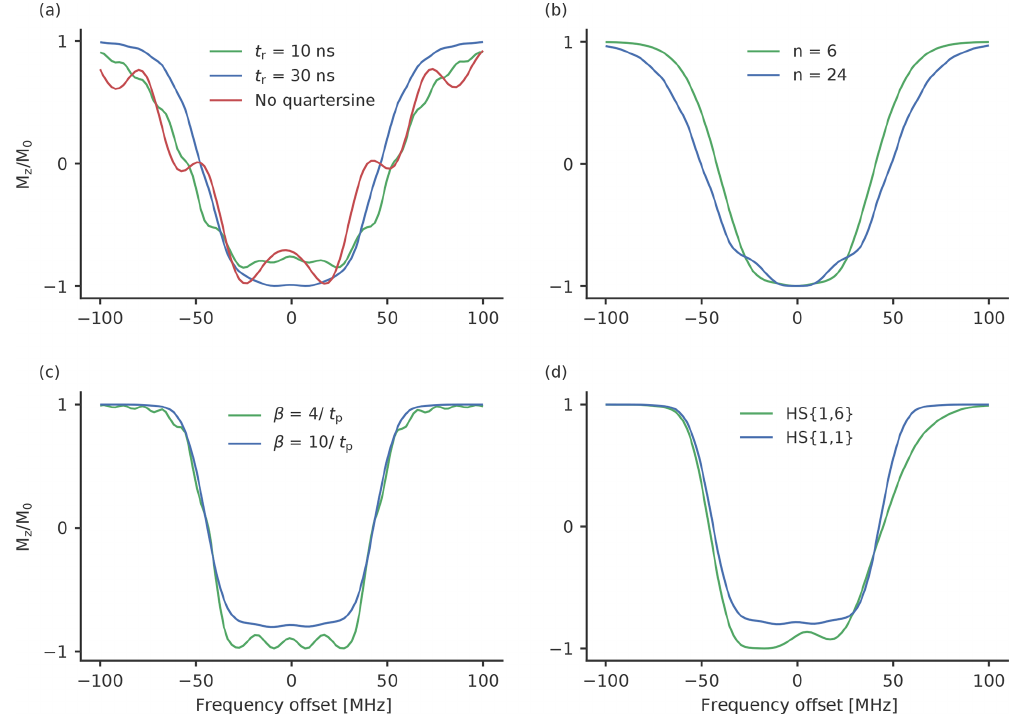
Figure 3. Calculated inversion profiles of broadband pulses normalised to ν 1 = 30MHz, which corresponds to the maximum of the measured resonator profile. (a) Chirp pulses with a frequency width of 120MHz, a length of 100ns and a rising time of 10ns (green), a rising time of 30ns (blue), a length of 36ns and no quarter sine smoothing (red). (b) WURST pulses with a frequency width of 120MHz, a pulse length of 100ns and a value for n of 6 (green) and 24 (blue). (c) HS { 1 , 1 } pulses with a frequency width of 90MHz and truncation parameters of 4 (green) and 10 (blue). (d) An HS { 1 , 6 } (green) and HS { 1 , 1 } (blue) pulse with a width of 90MHz and a pulse length of 100ns. The truncation parameter was 10 in both cases.